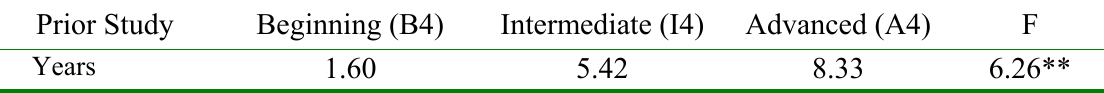
Analysis of Variance in Prior English